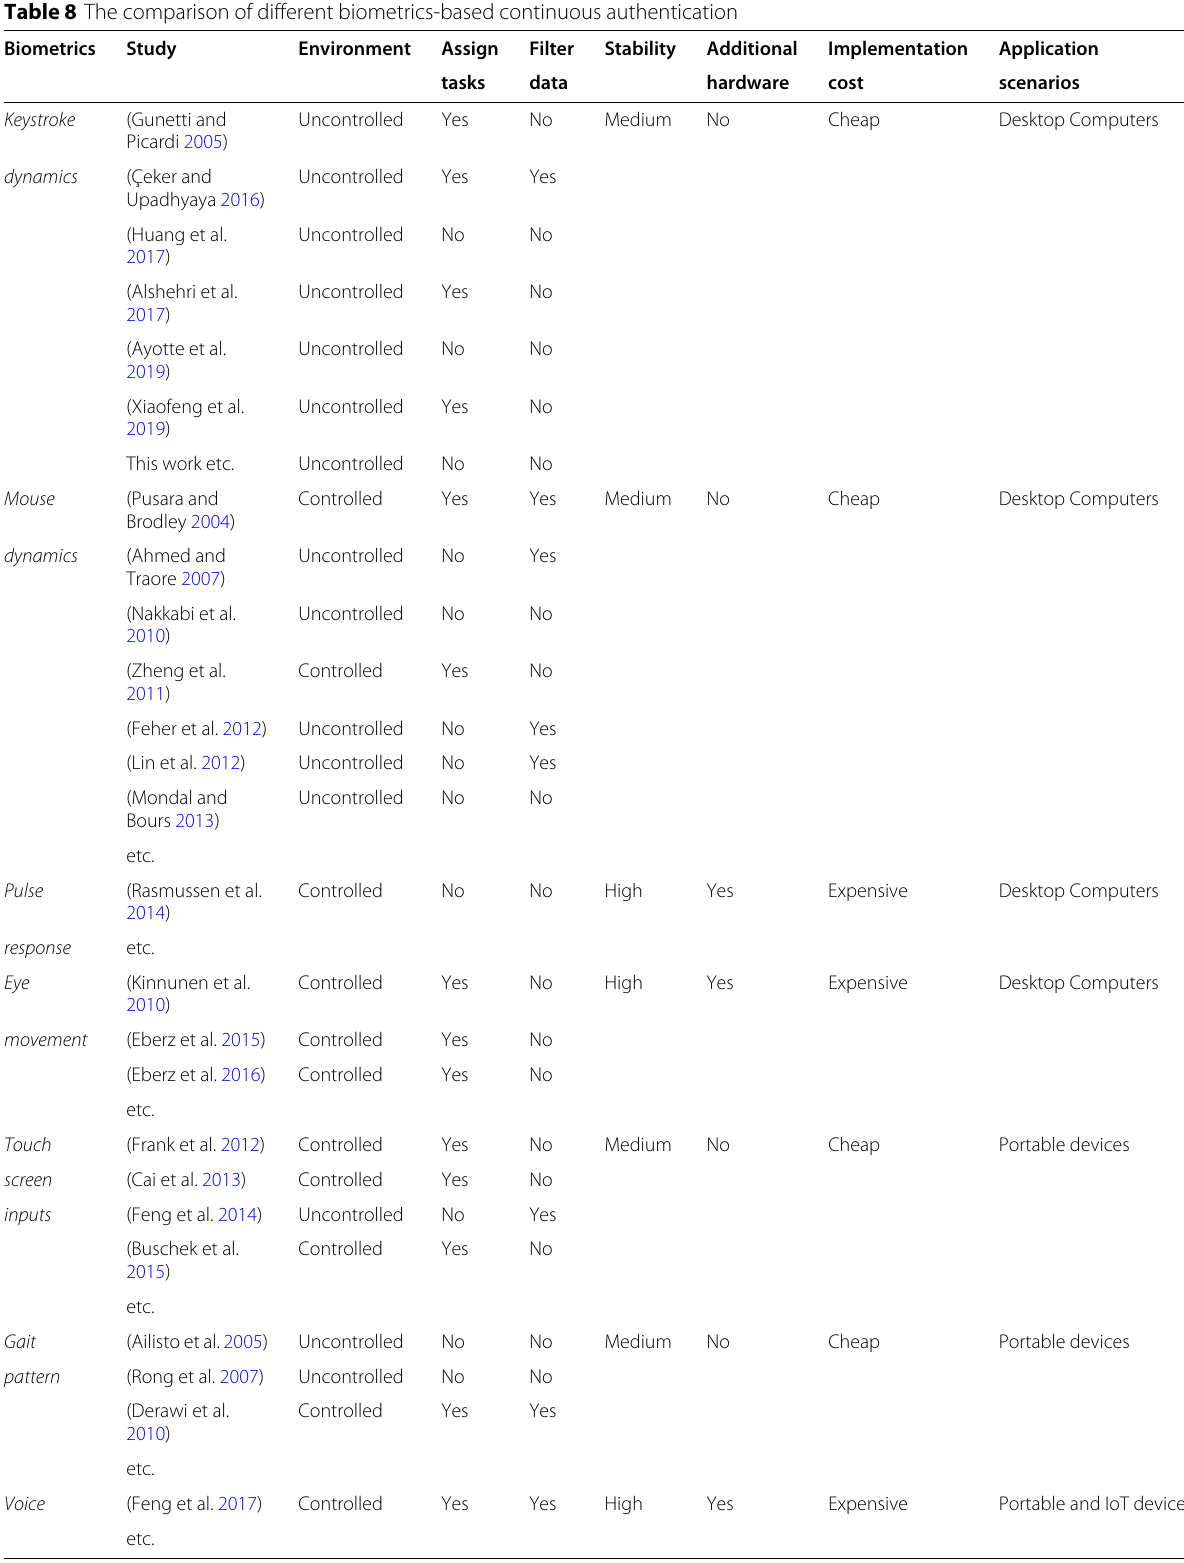
Table 8 The comparison of different biometrics-based continuous authentication